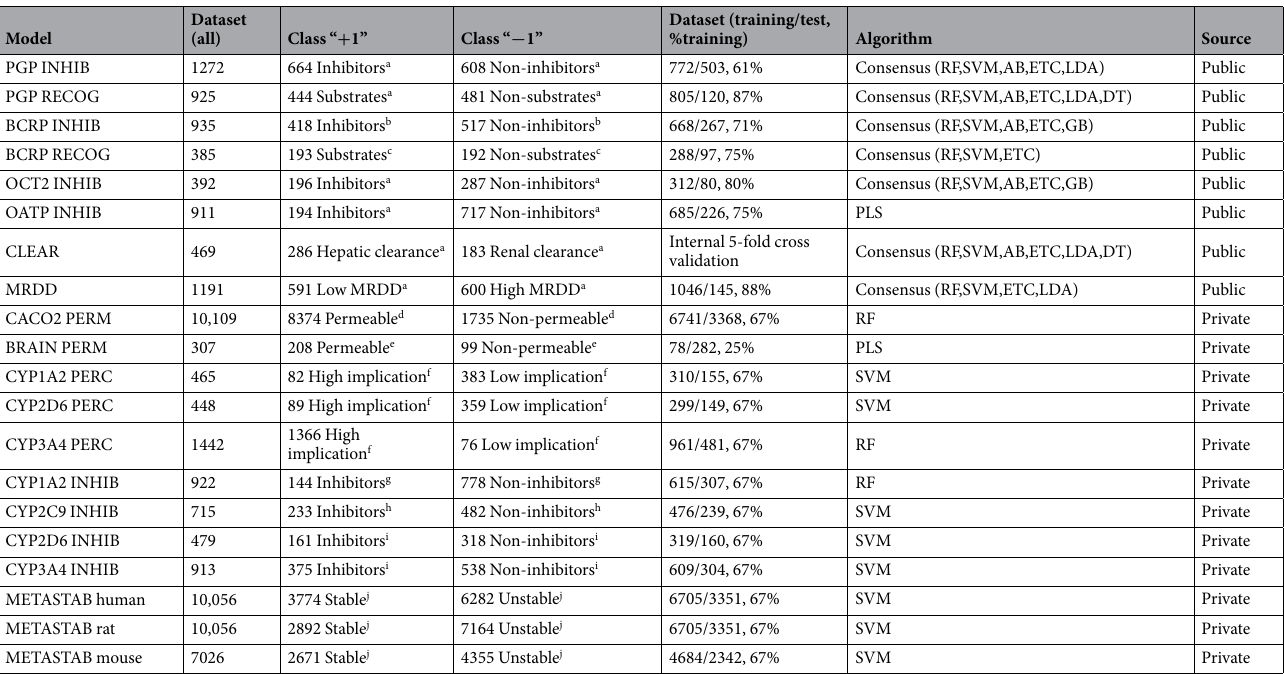
Table 1. In silico models information. a Compound categories are the same originally assigned by the authors of the works where data come from. b Compound categories thresholds for BCRP INHIB model are IC 50 ≤ 15 µ M or inhibition ≥ 50% for inhibitors and IC 50 > 50 µ M or inhibition < 30% for non-inhibitors. c Compound categories for BCRP RECOG model were assigned based on experimental transport proved for substrates and experimental lack of transport proved for non-substrates. d Fraction absorbed > 90% for permeable compounds and fraction absorbed < 40% for non-permeable compounds. e In silico prediction of the Blood Brain Barrier (BBB) permeability in vivo in rodent is based on experimental measurement of brain to plasma ratio of concentrations (Kp) in vivo at 2 time points after compound administration in rodents (Kp > 0,8 for permeable compounds and Kp < 0,2 for non-permeable compounds). f CYP implication > 70% for high implication compounds and CYP implication < 10% for low implication compounds. g IC 50 < 2 µ M for inhibitors